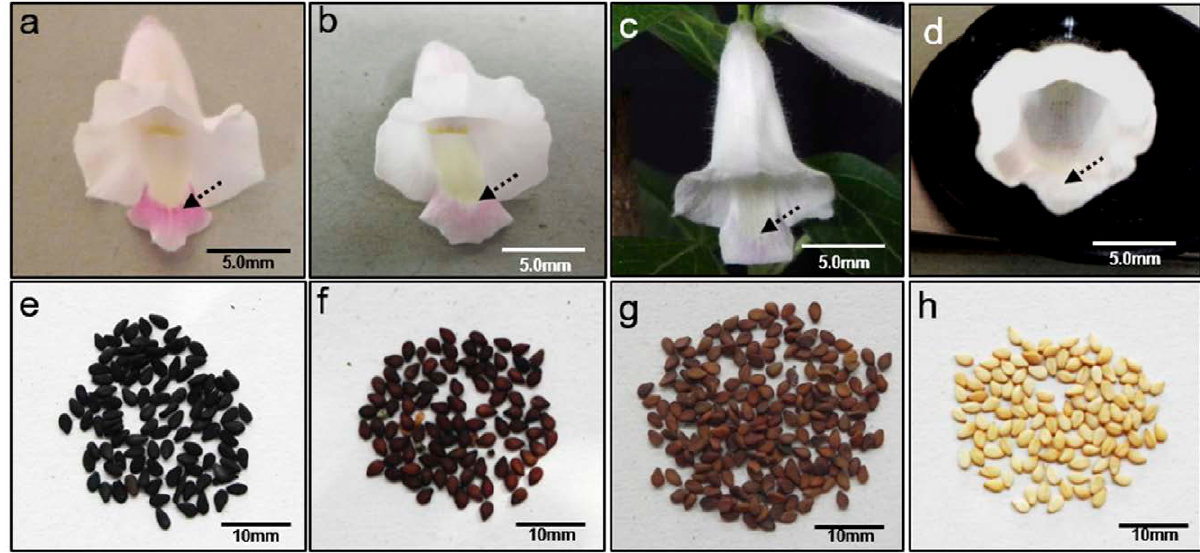
Figure 1. Flower and seed morphology of four Indian landraces of S. indicum . a & e) Black seeded til; b & f) Dark Brown seeded til; c & g) Light Brown seeded til; d & h) White seeded til. Dotted arrows indicate pigmentation patterns in lower lip of the